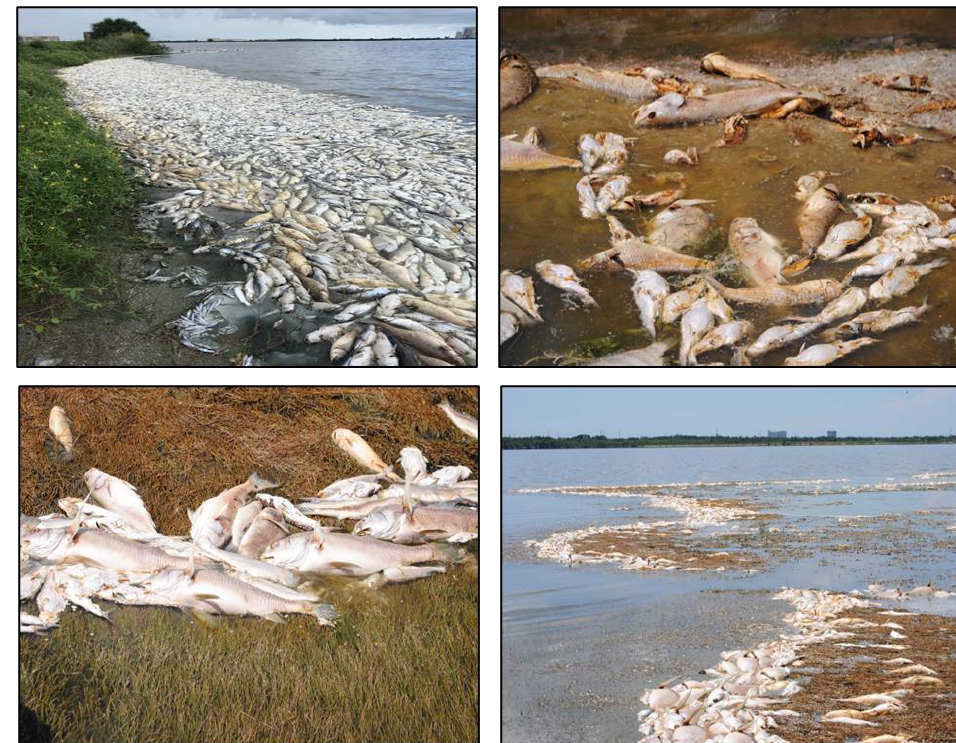
Figure A1. Tens of thousands of fish died during a major localized fish kill occurring in the